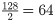
The different configurations of Hann windows of size 128x128 for edge and corner cases.Summing all the windows with the appropriate amount of overlap (1282=64 pixels in this example) makes every window applied to the reconstructed image sum to 1.